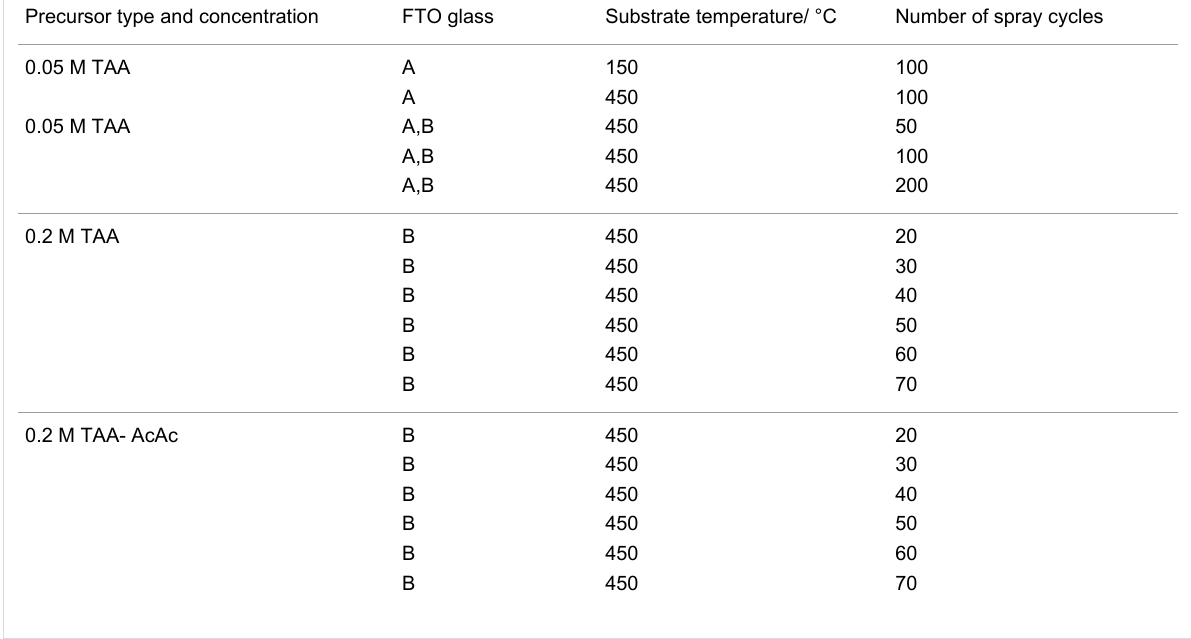
Table 1: Overview of the experimental conditions for spray deposition of titania blocking layers deposited on top of FTO conducting glass. Precursor type and